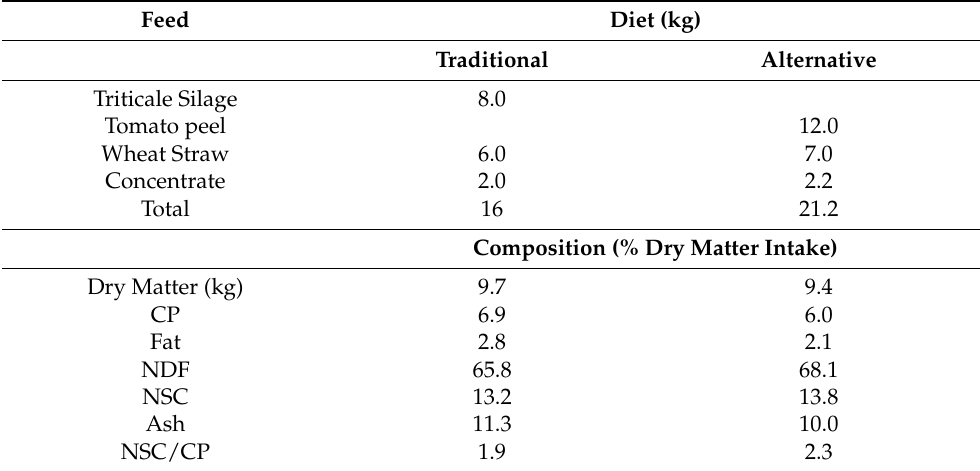
Table 1. Feed and chemical composition of buffalo diets characterized by different NSC/CP ratios in traditionally and alternatively fed